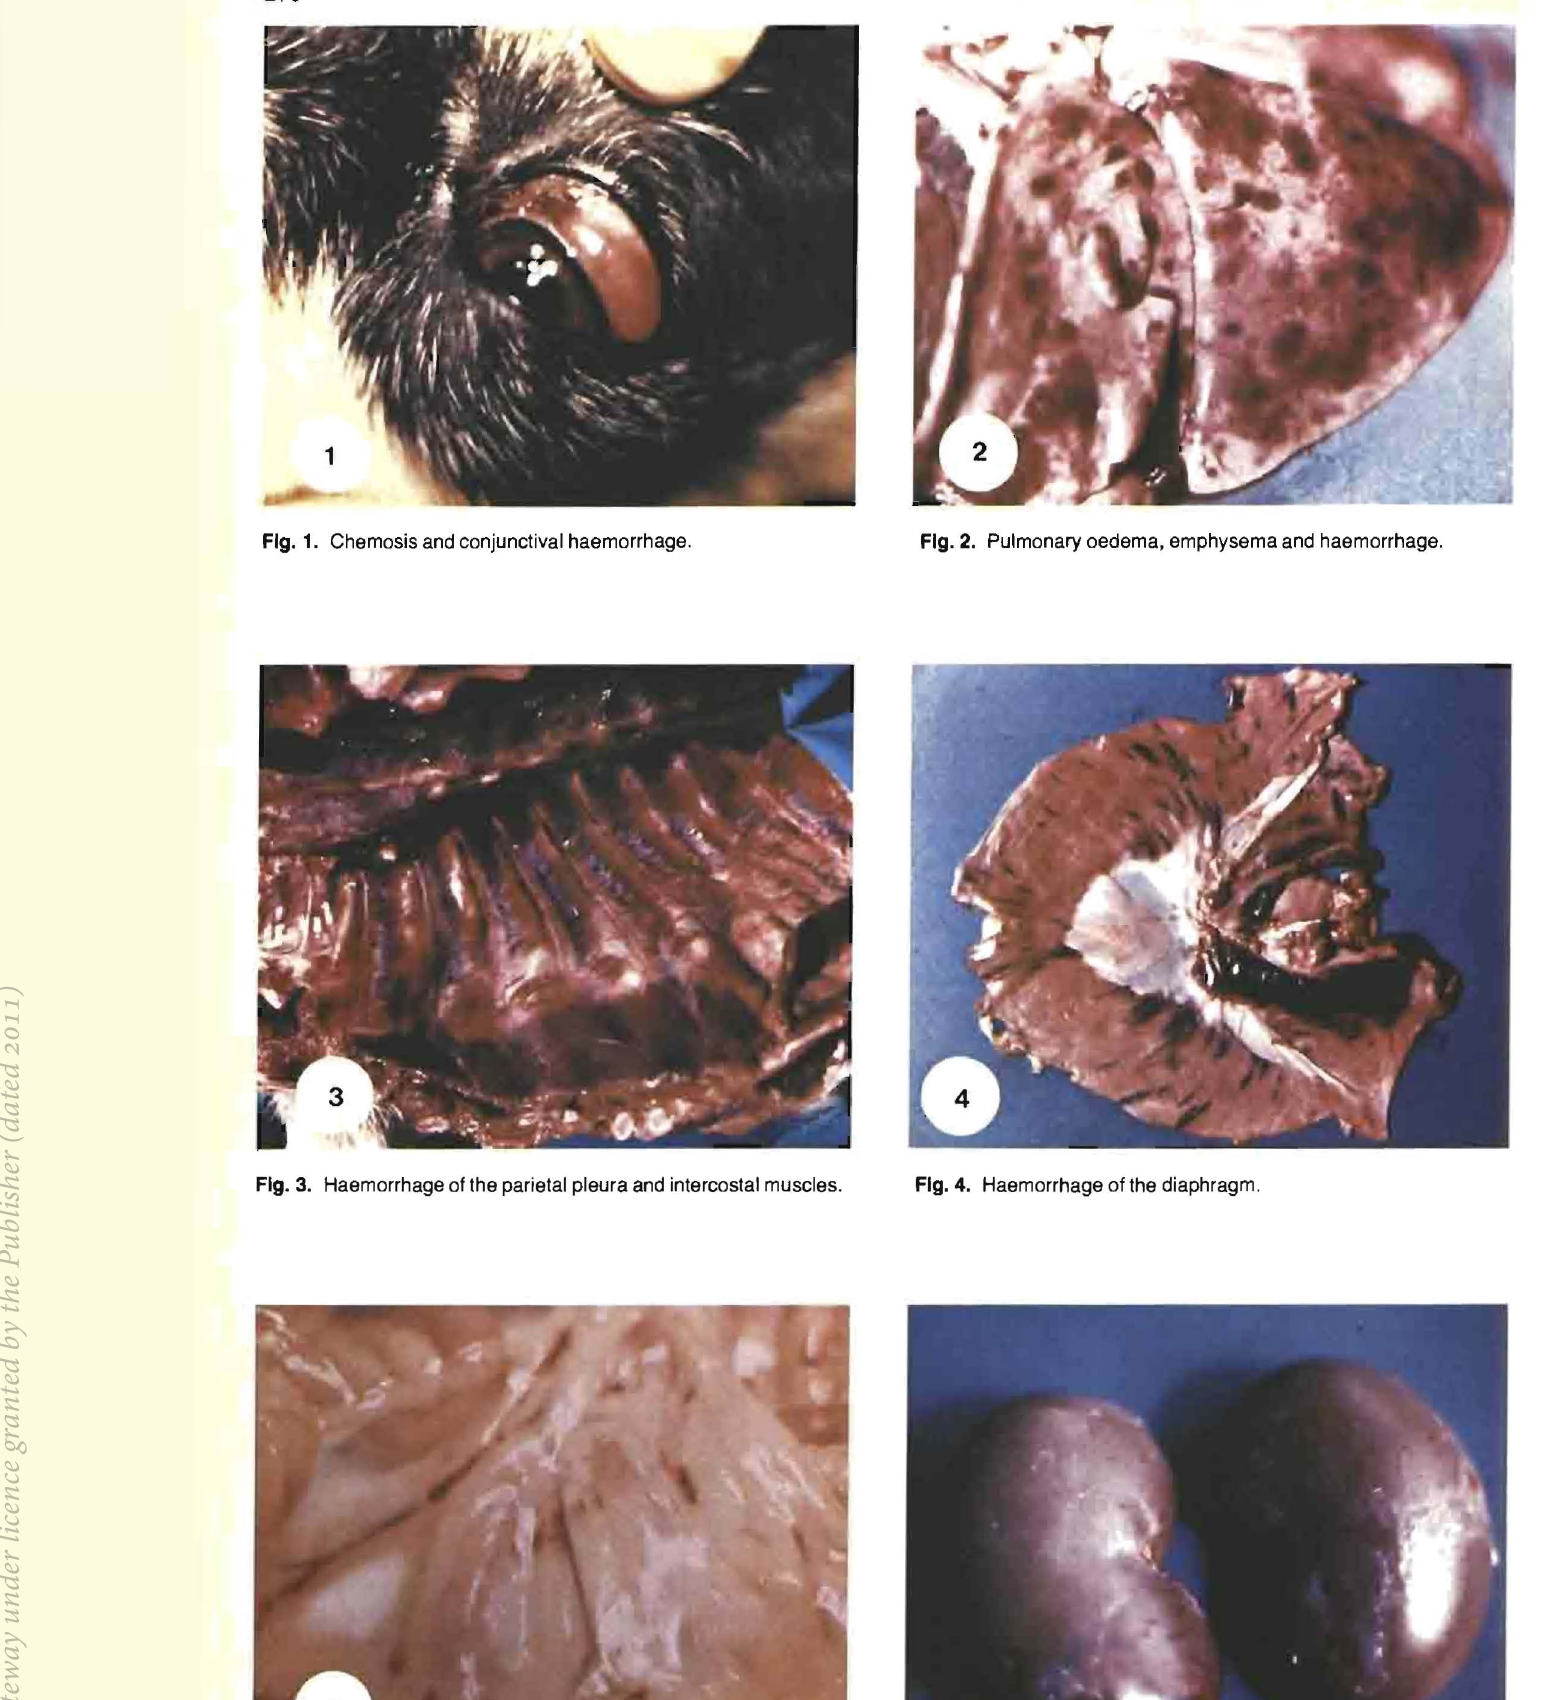
Fig. 6. Renal cortical petechiae and a posterior polar infarct of the left kidney.